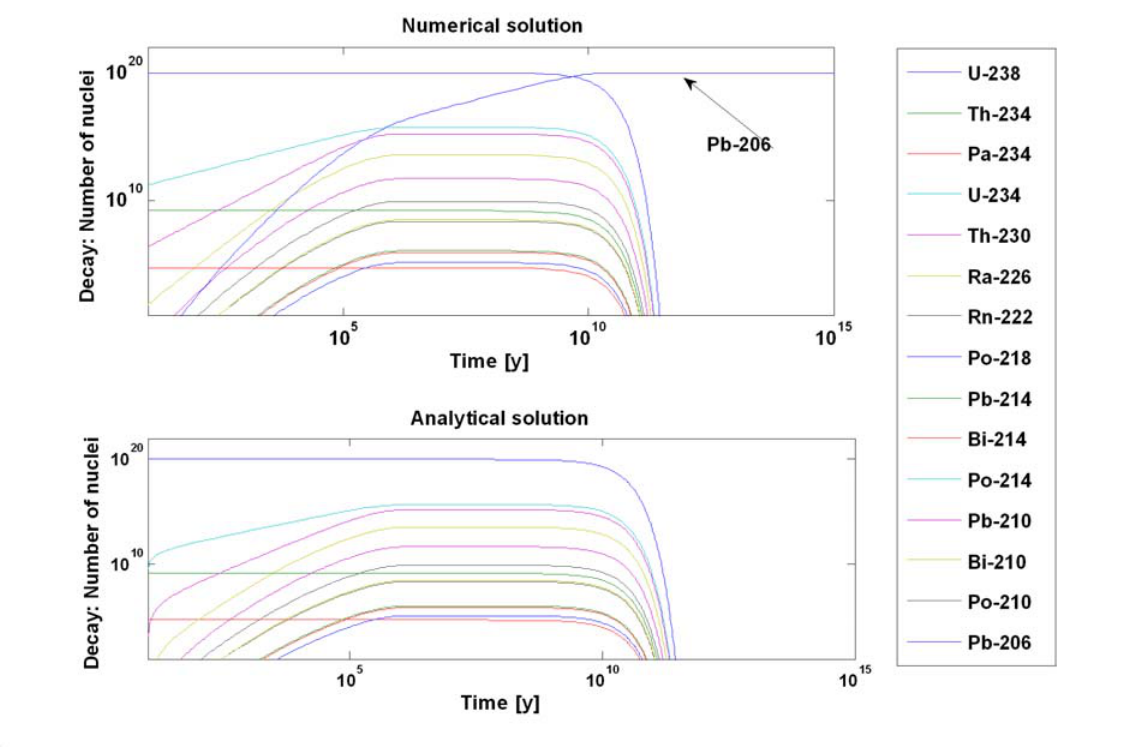
Fig. 1 Numerical and analytical solutions for the 238 U decay chain over the time period of 10 15 y with the initial condition: number of 238 U nuclei =10 20 .